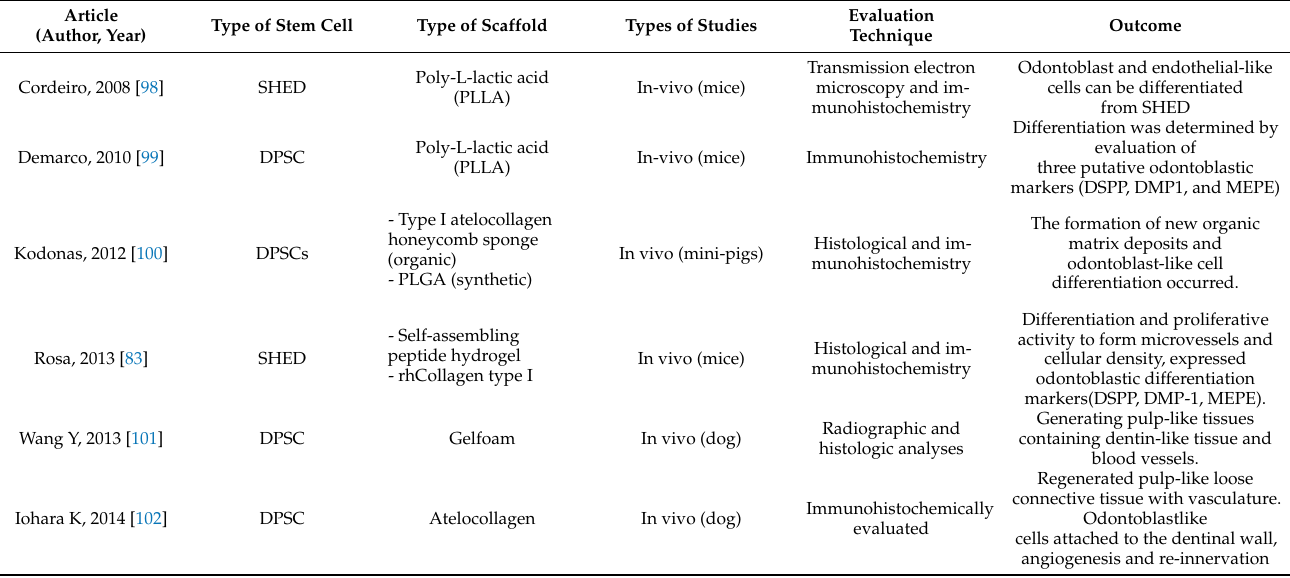
Table 1. Stem cells for dental pulp regeneration